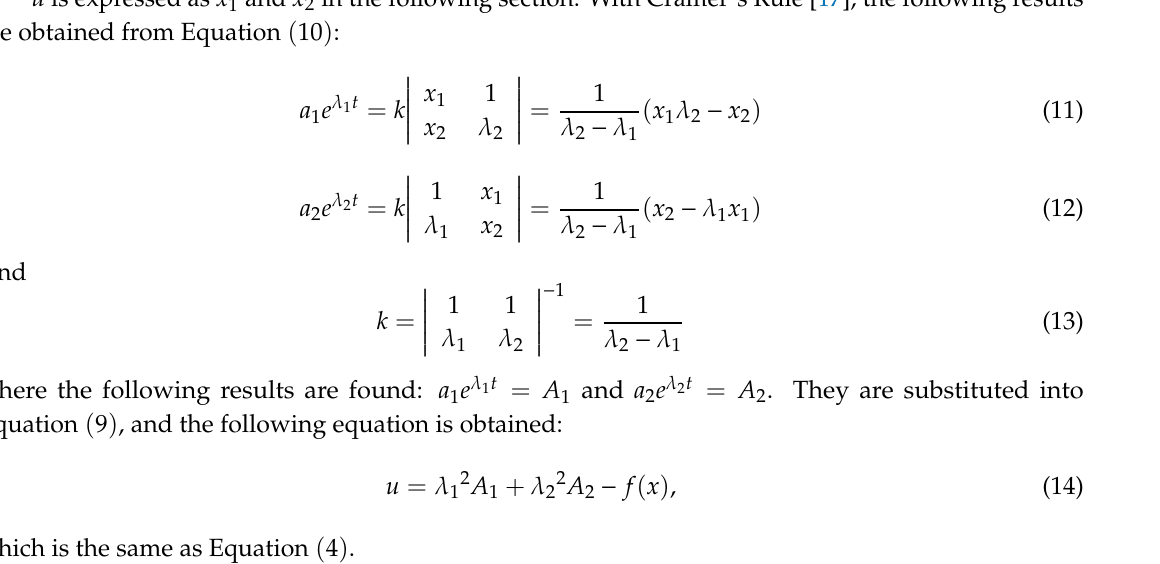
Figure 6. Time response of system with known parameters (without disturbance, 1 2 2, 3 λ λ= − = − . Figure 7. Phase diagram of system with known parameters (without disturbance, 1